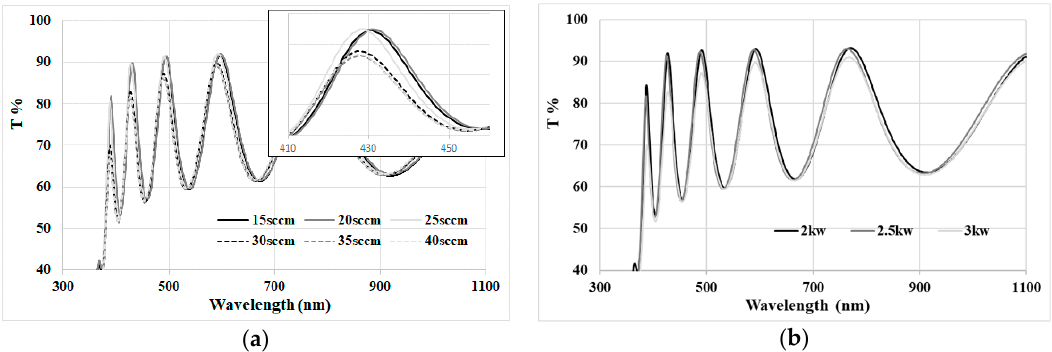
Figure 4. The transmittance for the samples with varying oxygen flows ( a ) and microwave power ( b ), the insert in ( a ) shows two groups of transmittances.